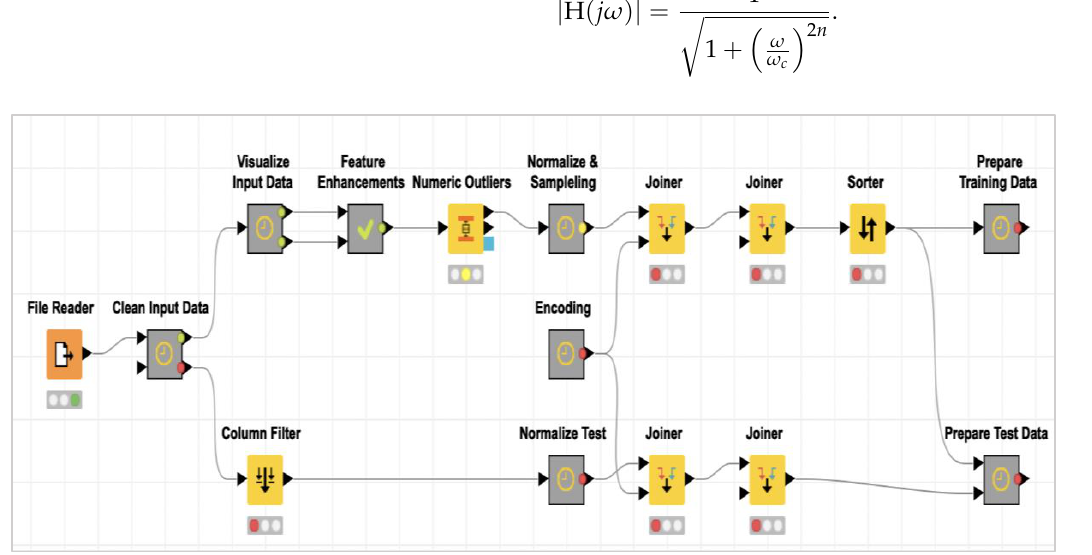
Figure 8. Preprocessing workflow to build a dataset.